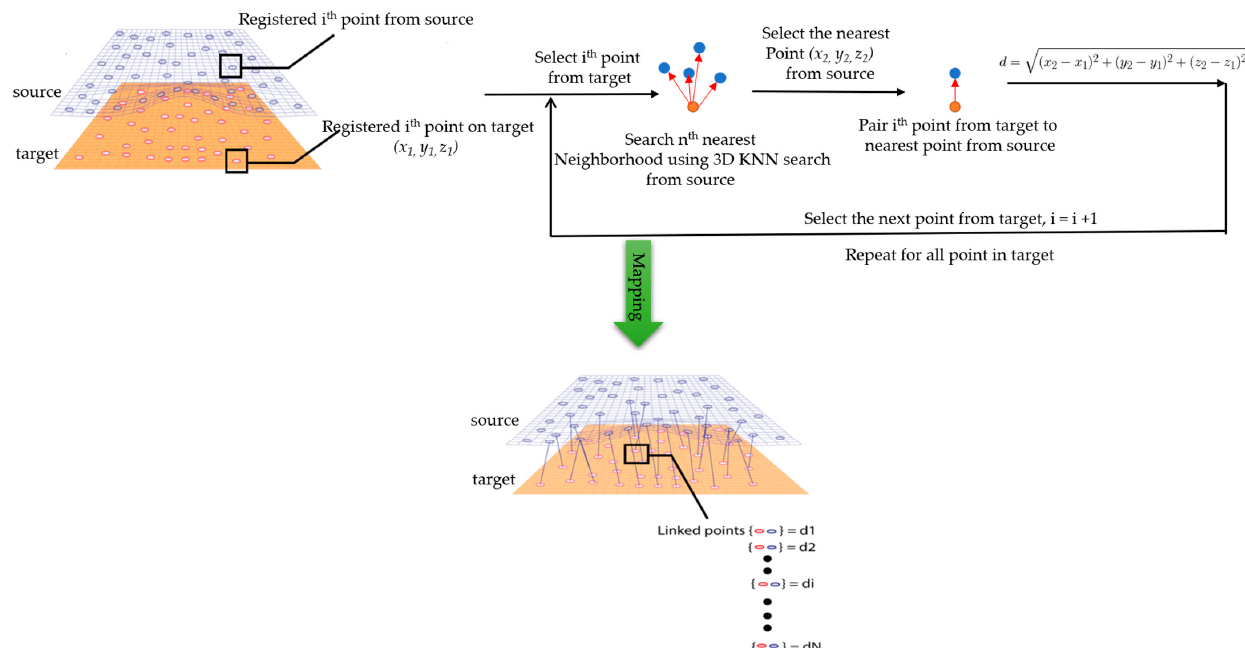
Figure 3. Sketch of the P2P distance analysis.